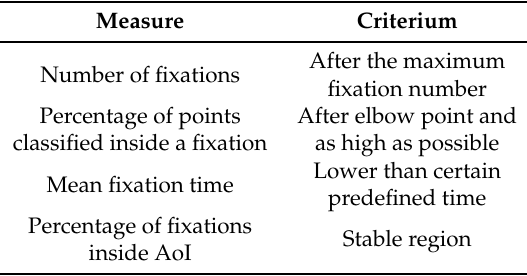
Table 1. Calibration criteria of the features.